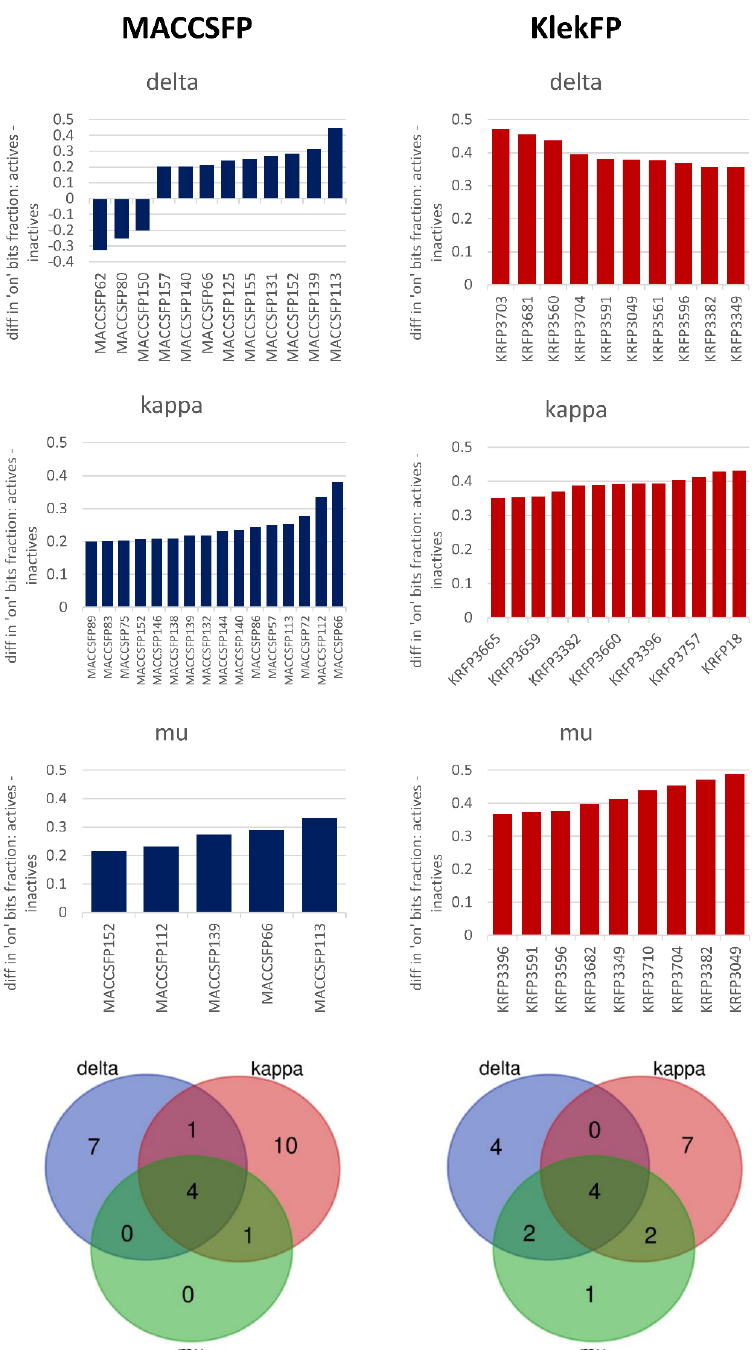
Figure 9. Keys with the highest differences in “on” bit frequency between active and inactive compounds. Venn diagram presents overlap of keys for different targets considered.